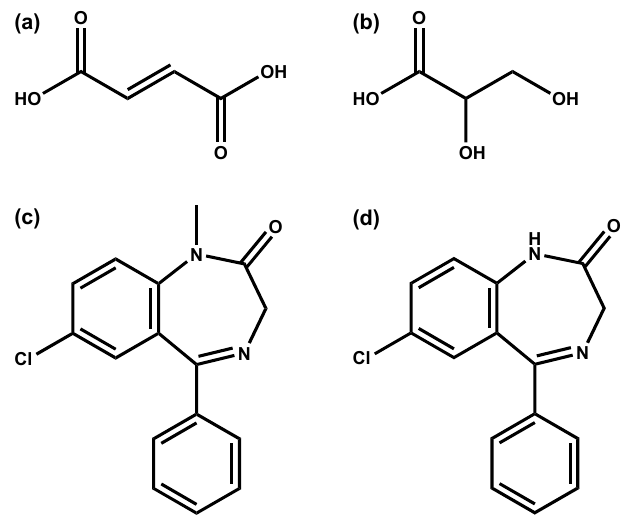
Figure 2. Chemical structures of ( a ) fumaric acid, ( b ) glyceric acid, ( c ) diazepam and ( d ) nordiazepam. For morphine, five endogenous molecules from the targeted workflow were found to significantly correlate with its time-dependent postmortem behavior, namely methionine, phenylalanine, valine, isoleucine and proline (Table 3). None of these amino acids did show a significant correlation with morphine concentration changes in the previously conducted proof-of-concept study [17]. Previously, significant negative correlations of morphine